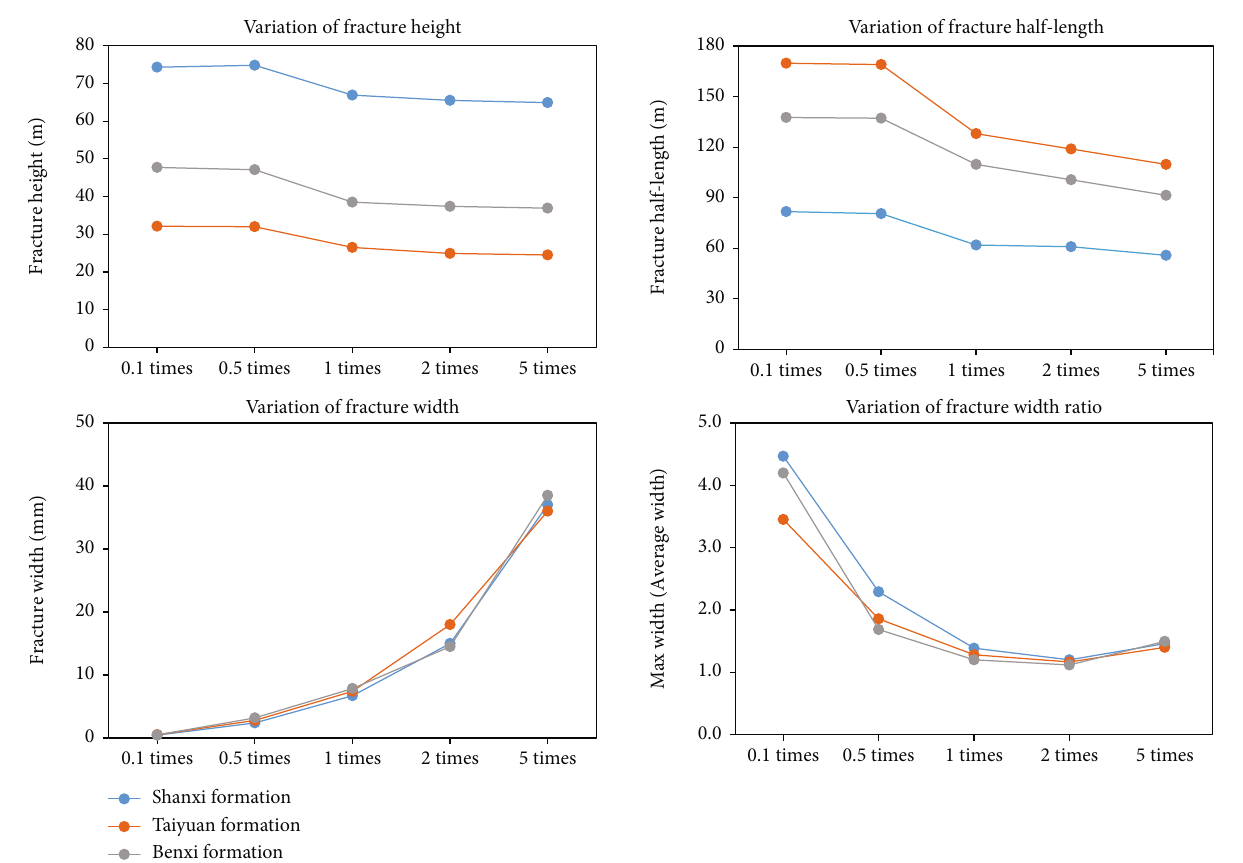
Figure 13: Variation of hydraulic fracture shape with the proppant